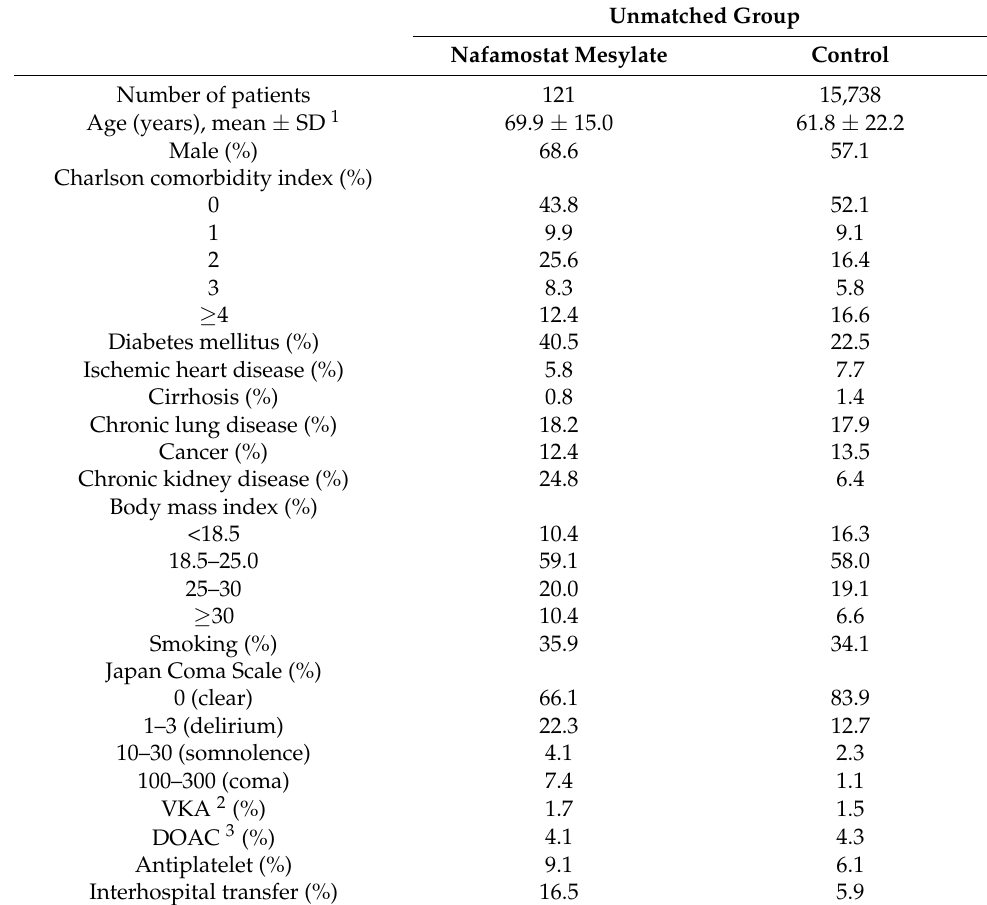
Table 1. Unmatched patient characteristics categorized according to nafamostat mesylate use.